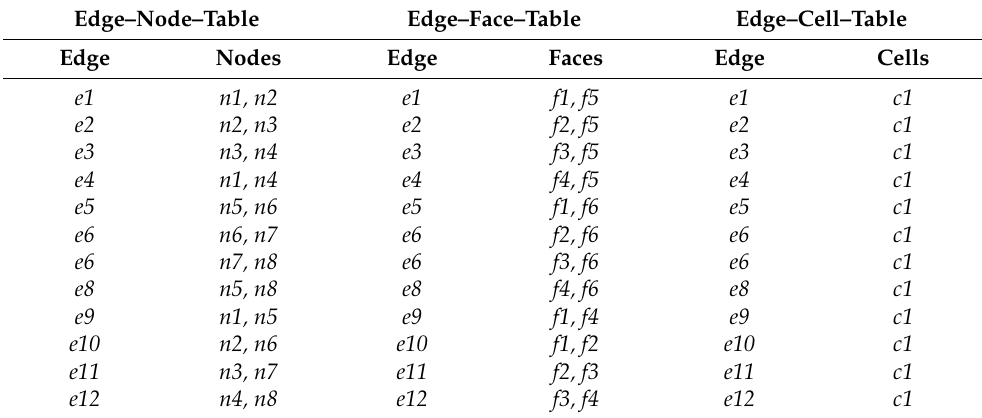
Table 2. Topological Tables (edge–node, edge–face and edge–cell) for a unit cube.